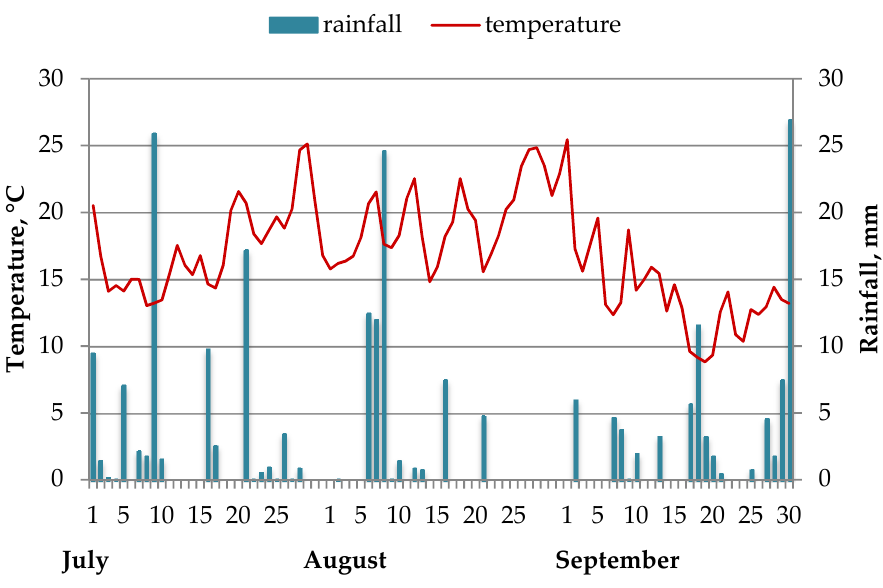
Figure 1. Daily temperature and rainfall before